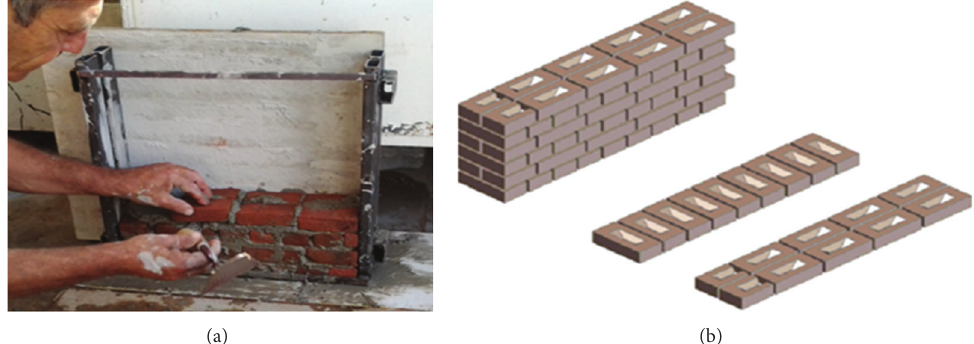
Figure 4: The wall samples prepared the dimensions 400 × 400 × 100 mm.